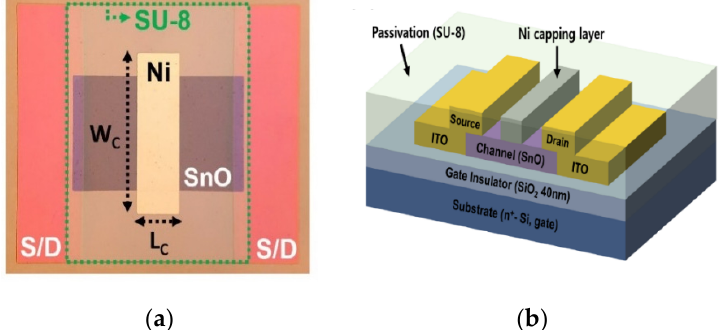
Figure 1. ( a ) Schematic structure; and ( b ) optical microscope image of p-channel SnO TFT with floating Ni capping